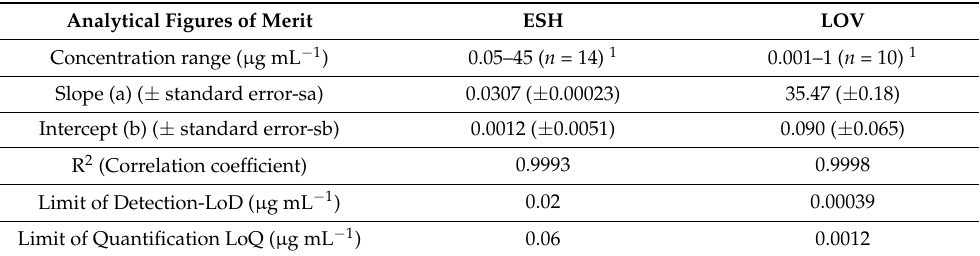
Table 1. Analytical figures of the merit of liquid chromatography–mass spectrometry (LC-MS) for ergothioneine (ESH) and lovastatin (LOV)